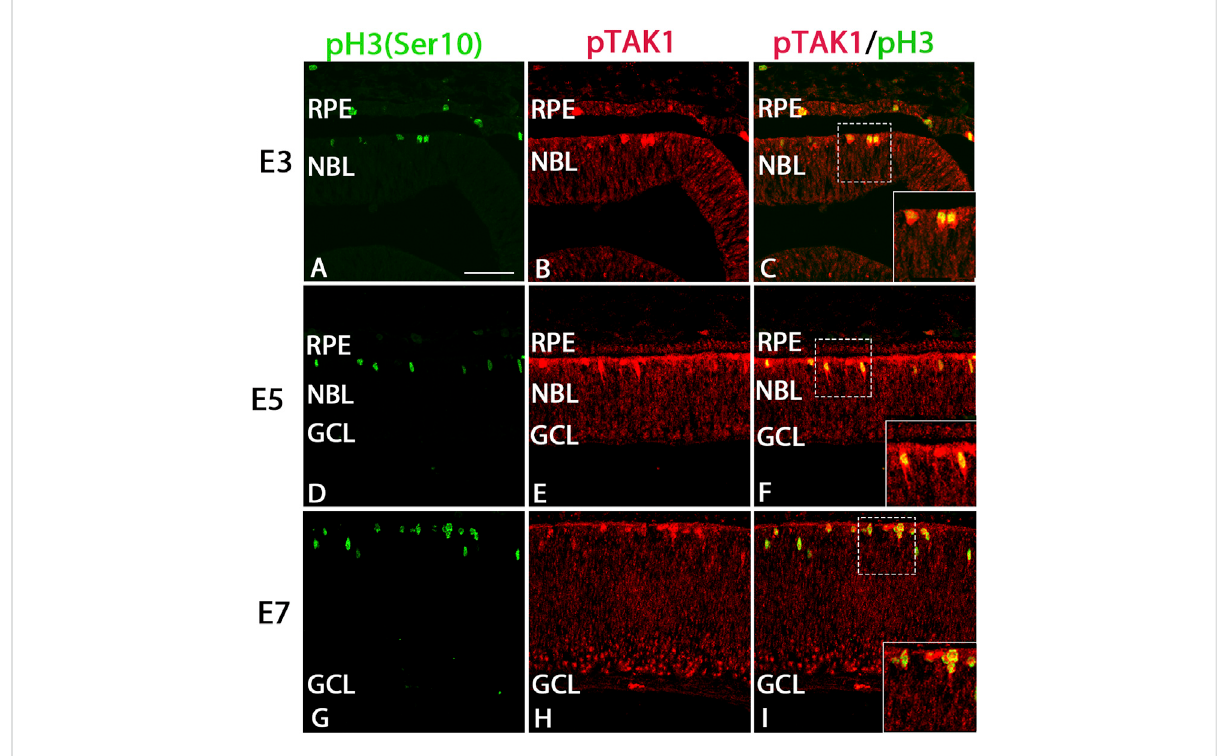
pTAK1 was co-localized to the phospho-histone 3 + (pH3 + ) dividing cells of the early chick retina. Chick retinal sections from E3, E5, and E7 embryos were double-labeled for pH3 (A,D,G) and pTAK1 (B,E,H) . Co-label is shown in (C,F,I) . Dashed boxes in (C,F,I) are shown at higher magni fi cationininsetsin (C,F,I) . Abbreviations:RPE, retinal pigmented epithelium;NBL,neuroblast layer;GCL,ganglion celllayer.ScalebarinA=50 μ m for images (A – I)